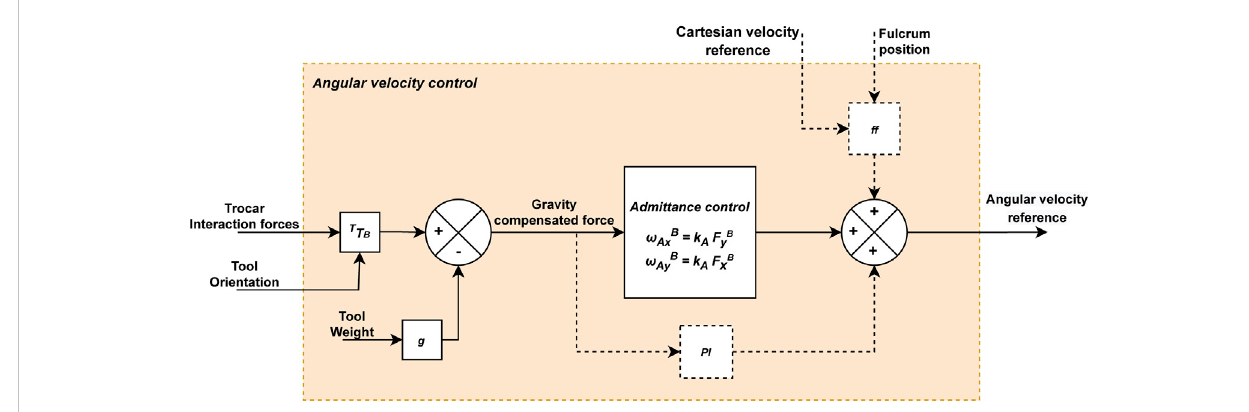
FIGURE 5 Diagram of the force-based angular velocity control for the laparoscope. The dashed lines connect elements that are only activated by moving the laparoscope ’ s tip.